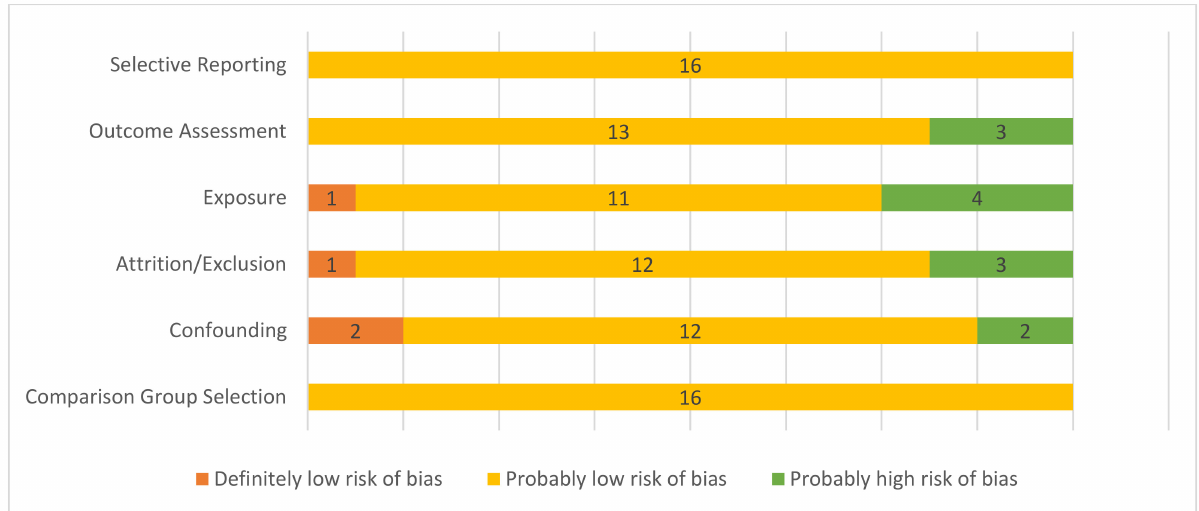
Figure 2. Risk of bias summary for included studies. Definitely low risk of bias = direct evidence of low risk-of-bias practices; probably low risk of bias = indirect evidence of low risk-of bias practices or deviations would not appreciably bias results; probably high risk of bias = indirect evidence of high risk-of-bias practices or insufficient information provided for evaluation